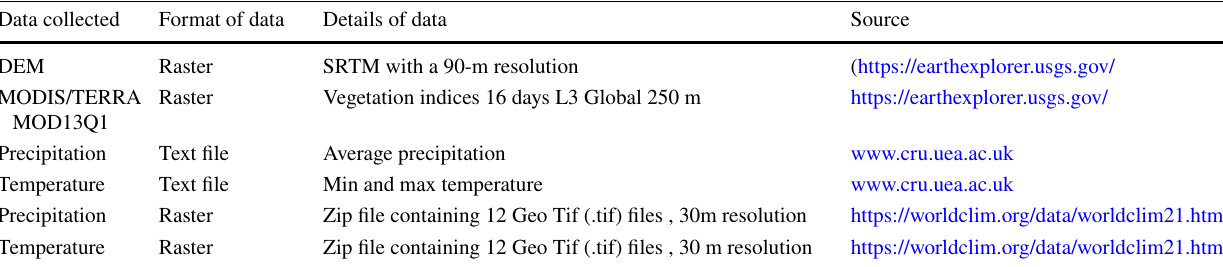
Table 1 Hydrometeorological data collected Data